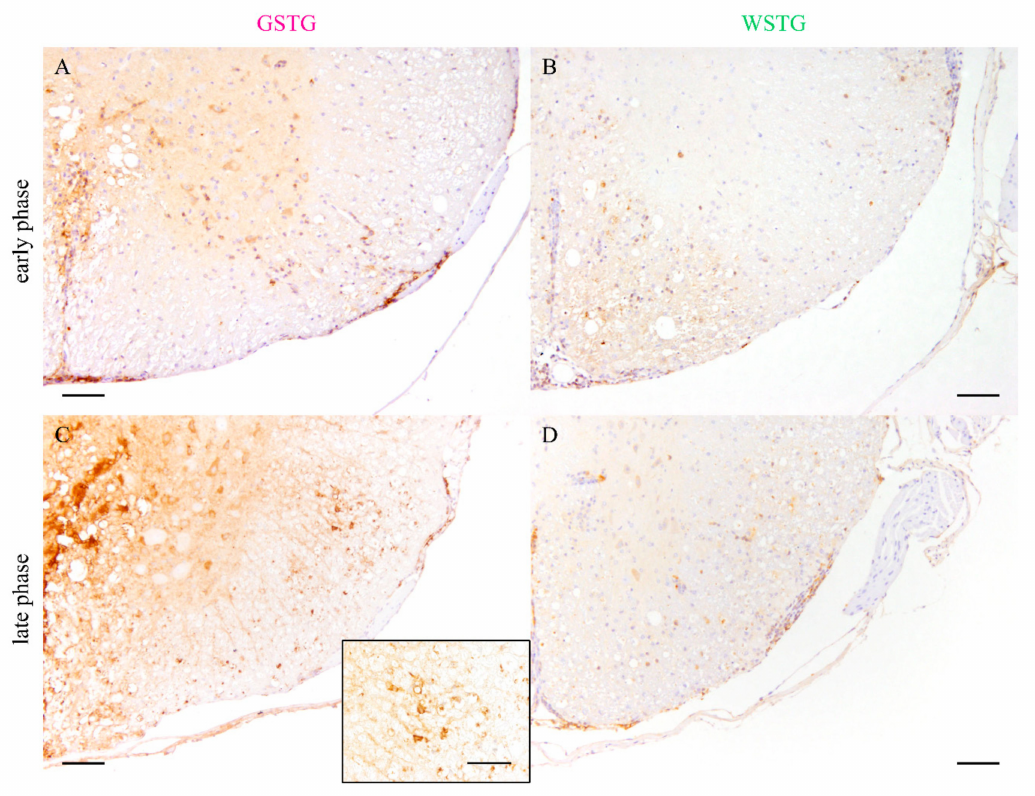
Figure 6. Detection of vascular leakage. Immunohistochemistry targeting CD34 was used for the detection of vascular leakage within the spinal cord white matter. Variable CD34 labeling was predominantly observed in the ventral part of the cervical and thoracic spinal cord white matter at 46 (early phase; A , B ) and 77 (late phase; C , D ) days post infection in all groups. CD34 labeling is shown in higher magnification (insert in C ). Bars represent 100 µ m in the overviews and 50 µ m in the insert. 2.6. Quantification of Inflammation and Immunophenotyping of Inflammatory Cells Scoring of meningitis and perivascular inflammation in the cervical and thoracic spinal cord white matter was performed to investigate the impact of astrocyte depletion upon inflammation (Figure 7). At 77 dpi, a reduced degree of meningitis in the cervical and thoracic spinal cord of GSTG mice was detected (Figure 7). Perivascular inflammation was significantly reduced in GSTG mice in the cervical white matter at 6 dpi and in the thoracic white matter at 77